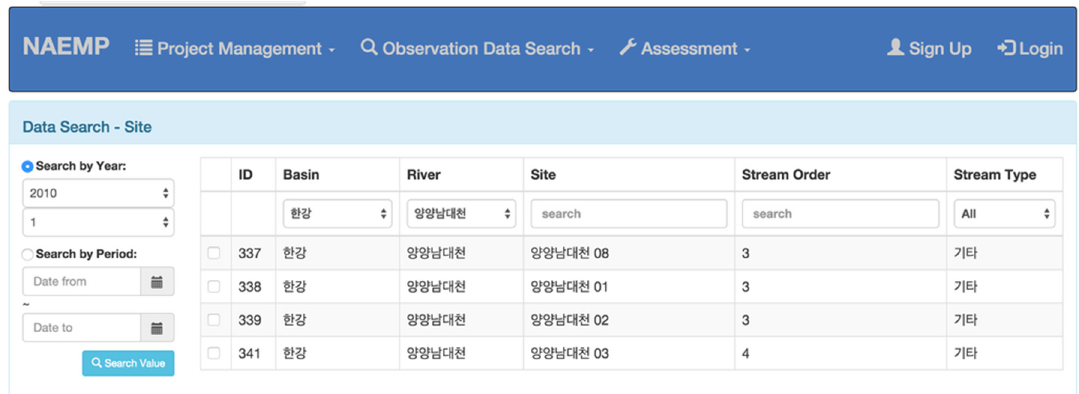
Figure 13. Observation data collected at selected sites. Figure 14. Observation data in the chart window.